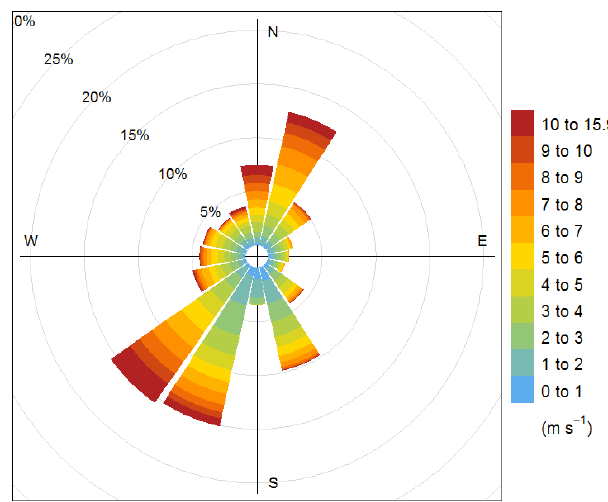
Figure 2. Wintertime (December–February) frequency distribution of wind directions at 82m height at the Hegyhátsál tall-tower moni- toring site between December 2015 and February 2021. The village is located to the northwest of the tower.